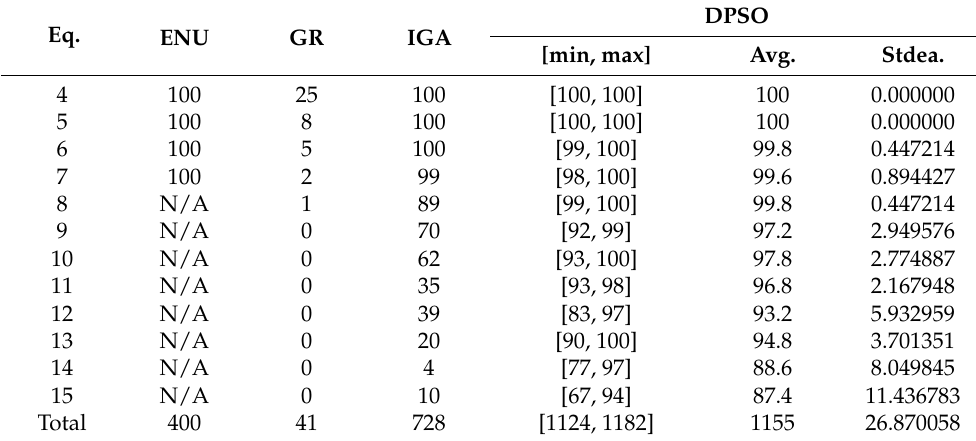
Table 7. Multi-algorithm success number comparison table.